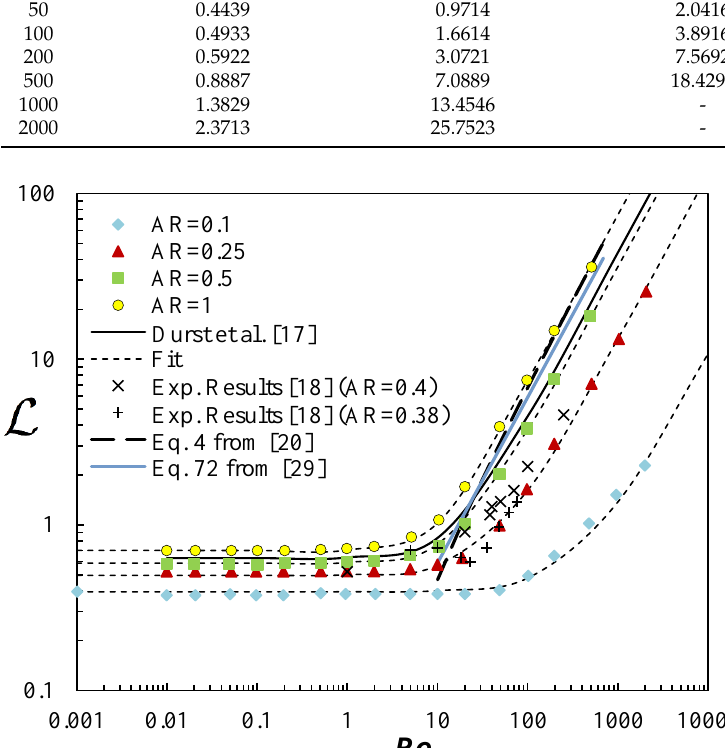
Figure 2. Development length L for different AR , compared against the experimental results given in [18]. The dashed lines show the fit obtained with the correlation given in Equation (6). We also show a comparison with the correlation proposed in [20], and a good agreement is observed (except for low Re where the correlation proposed by [20] fails). The correlation proposed in [29] also shows good agreement with the correlation proposed in [20] (in [20], several correlations are developed to account for different duct